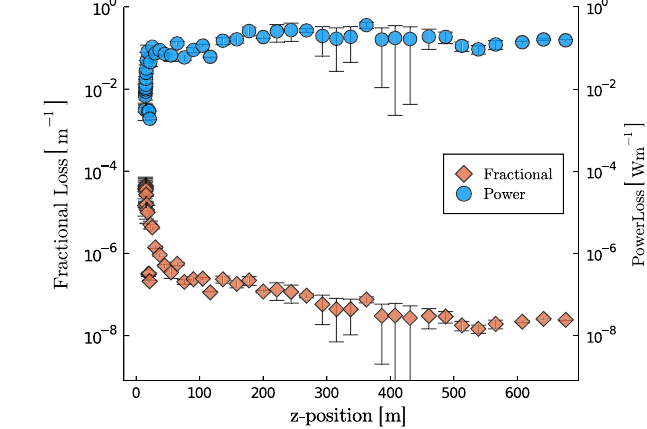
FIG. 4. Stripping losses, as per Eq. (7), and corresponding power loss rate along a pulsed 62.5 mA H − beam in a super- conducting linac accelerating to 2.5 GeV with a 4% duty cycle (nominal ESS = ESS ν SB upgrade design